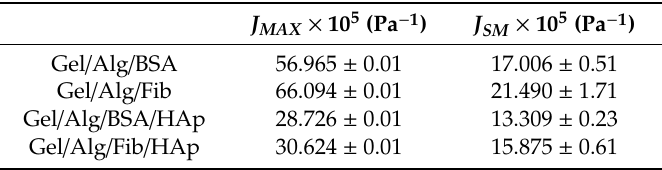
Table 4. Maximum compliance and compliance of the Maxwell spring.